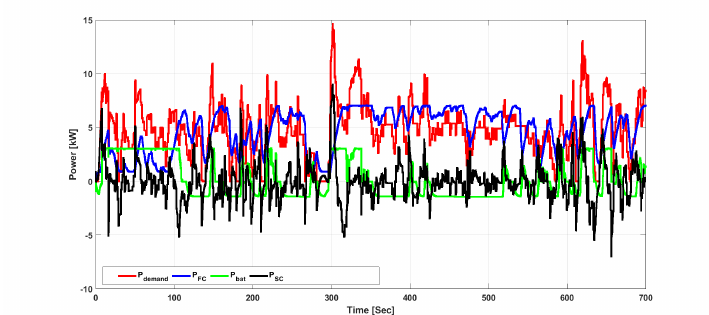
Figure 10. Power demand ( P demand ), FC power ( P FC ), battery power ( P bat ), and supercapacitor power ( P SC ) for the EMS based on SMC.